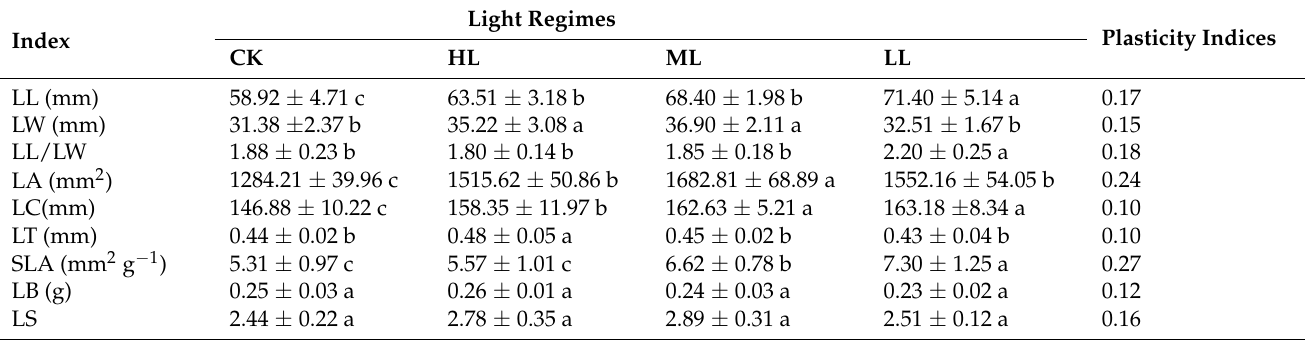
Table 1. Leaf morphological characteristics of C. oleifera under different light regimes.